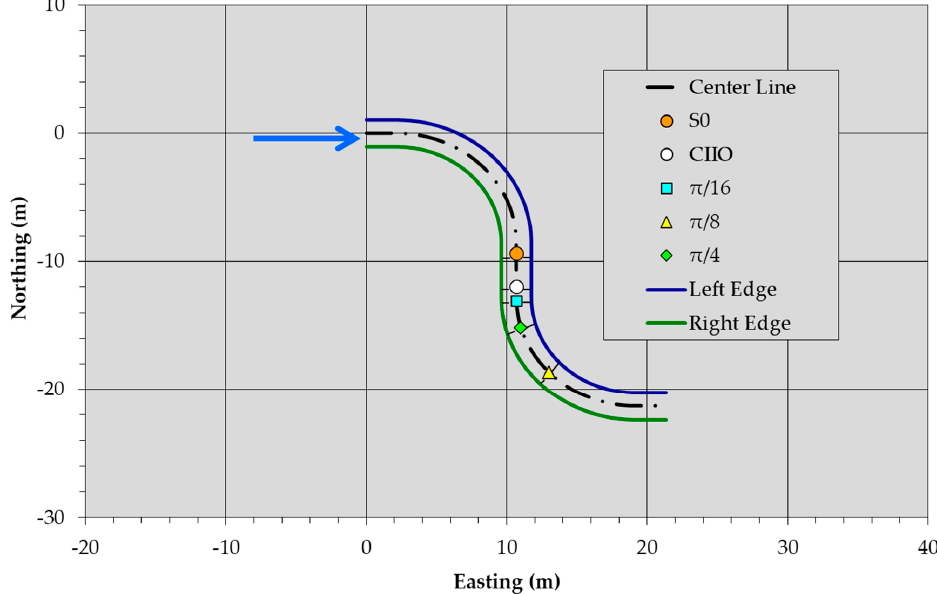
Figure 8. Plan-view of the open channel, physical model by Yen [58]. The positions of cross sections where velocity profiles were measured are identified as S0, CIIO, π /16, π /8, and π /4.